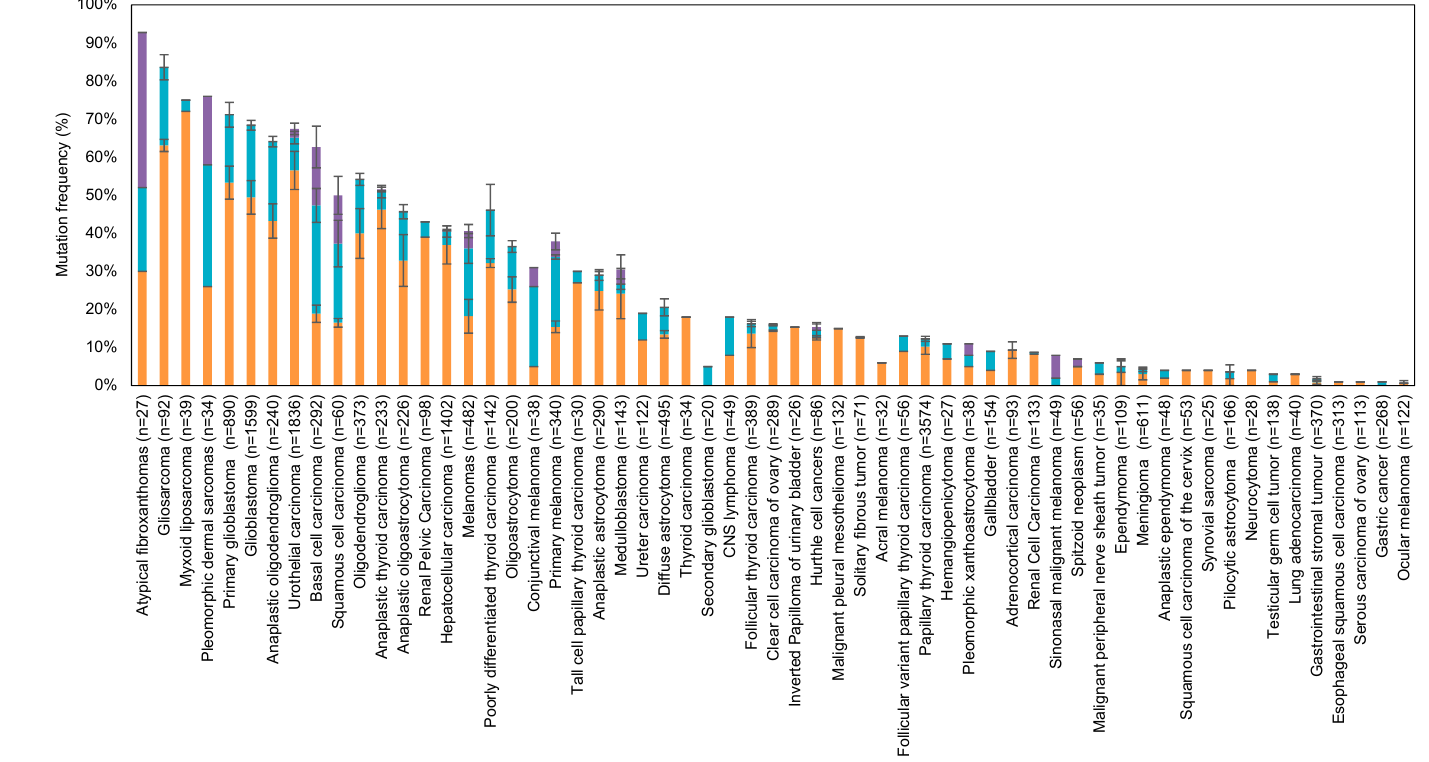
Figure 2. Frequency of human telomerase reverse transcriptase ( hTERT ) promoter mutations in various cancer types. ( a ) Overall hTERT promoter mutation frequencies of various cancer types plotted in descending order; ( b ) Overall hTERT promoter mutation frequencies of various cancer types with breakdown of individual frequencies of C228T, C250T, and all other mutations. The overall mutation frequencies of hTERT promoter were compiled from all relevant publications on human cancer genome sequencing. The label “ n ” corresponds to the total number of tumors sequenced among different studies for the same tumor type. Error bars correspond to the standard errors in mutation frequencies calculated among different studies on the same tumor type. Only studies with at least 20 samples sequenced were included in this study. Only studies which provided the detailed breakdown of different mutation sites were included in ( b ). Refer to Table 3 for the list of references used to compile this